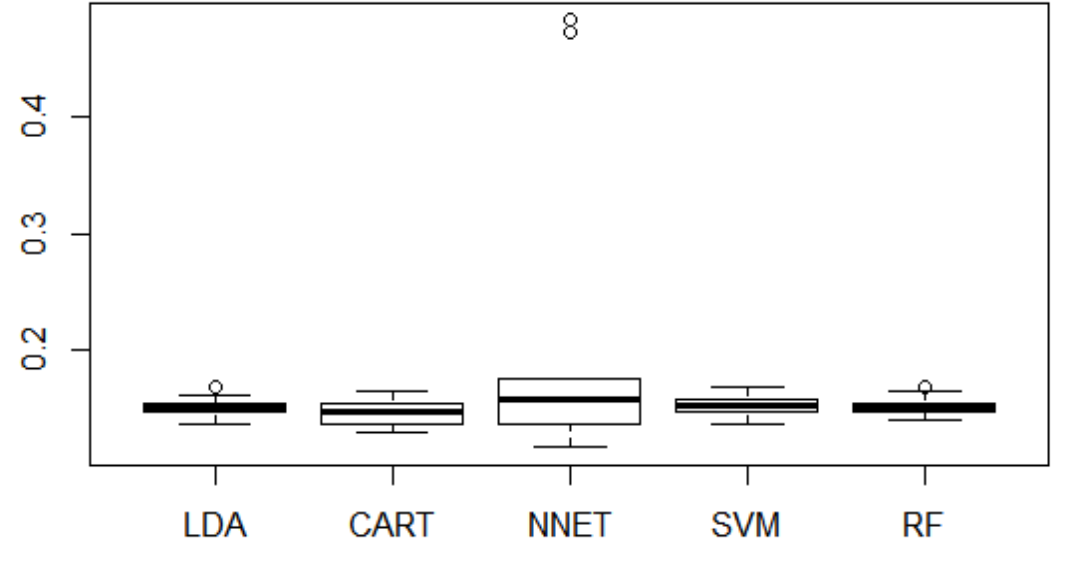
Figure 2. Misclassification Rates in 100 Simulations.